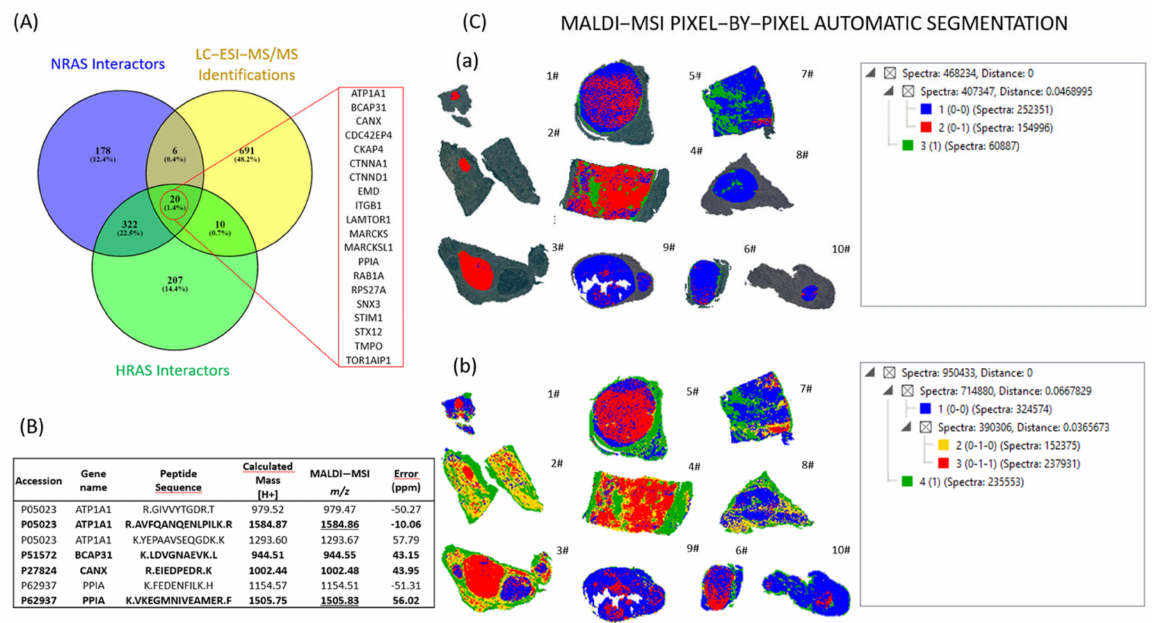
Figure 4. Integration of RAS protein–protein interaction analysis and LC–ESI-MS/MS and MALDI– MSI results. ( A ). Venn diagram showing the number of common proteins among the NRAS protein interactors; HRAS protein interactors and proteins putatively identified in the MALDI-matrix by LC–ESI-MS/MS. ( B ). List of proteins found in MALDI–MSI analysis and putatively identified with an error lower than 100 ppm; in bold are signals uniquely identified and all the signals used for the automatic segmentation are underlined. ( C ). MALDI–MSI-based automatic segmentation using (a) only the NIFTPs ROIs annotated by the pathologists and (b) all the tissue